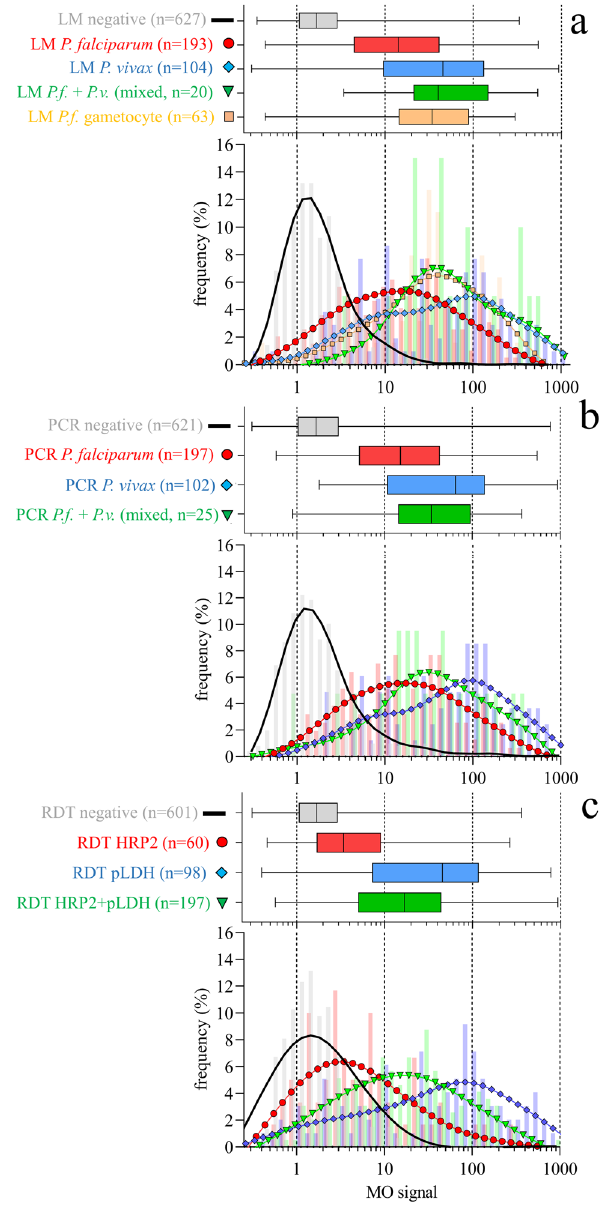
Fig. 2 RMOD data in comparison to different reference methods. a Expert LM, ( b ) PCR and ( c ) RDT. The panels are divided into box-and-whisker plots (top) and histograms (bottom). The box-and-whisker plots show median, interquartile range (IQR), and range of the MO signals for the respective diagnostic results. The histograms show the raw distribution of MO signal data (bars) and a smoothened line resulting from applying generalized additive models of the MO signal frequency distributions for the respective diagnostic results. All panels share a common horizontal scale of MO signal. Color and symbol coding for each panel is given by the font color and the symbols next to the labels of the box-and-whisker plots. The number of independent biological samples is given as part of each label. Each biological sample was measured in